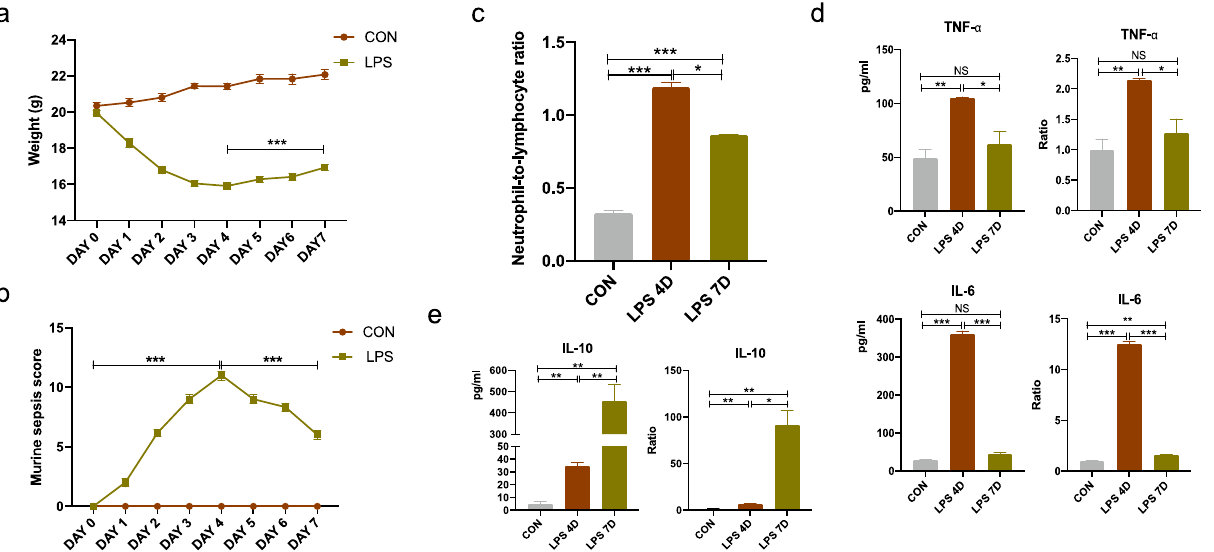
Figure 3. Reduced systemic inflammation in mice injected with LPS for 7 consecutive days. ( a ) Changes in body weight of mice. ( b ) Effects of LPS administration on murine sepsis score. ( c ) Ratio of neutrophils to lymphocytes in serum of each group of mice. ( d ) Expression of inflammatory factors TNF- α and IL-6 in mice serum measured by ELISA. ( e ) Expression of inflammatory factor IL-10 in mice serum measured by ELISA. NS indicates no statistical difference from the control group. * p < 0.05, ** p < 0.03, *** p < 0.01 compared with control, n = 6 mice per group.